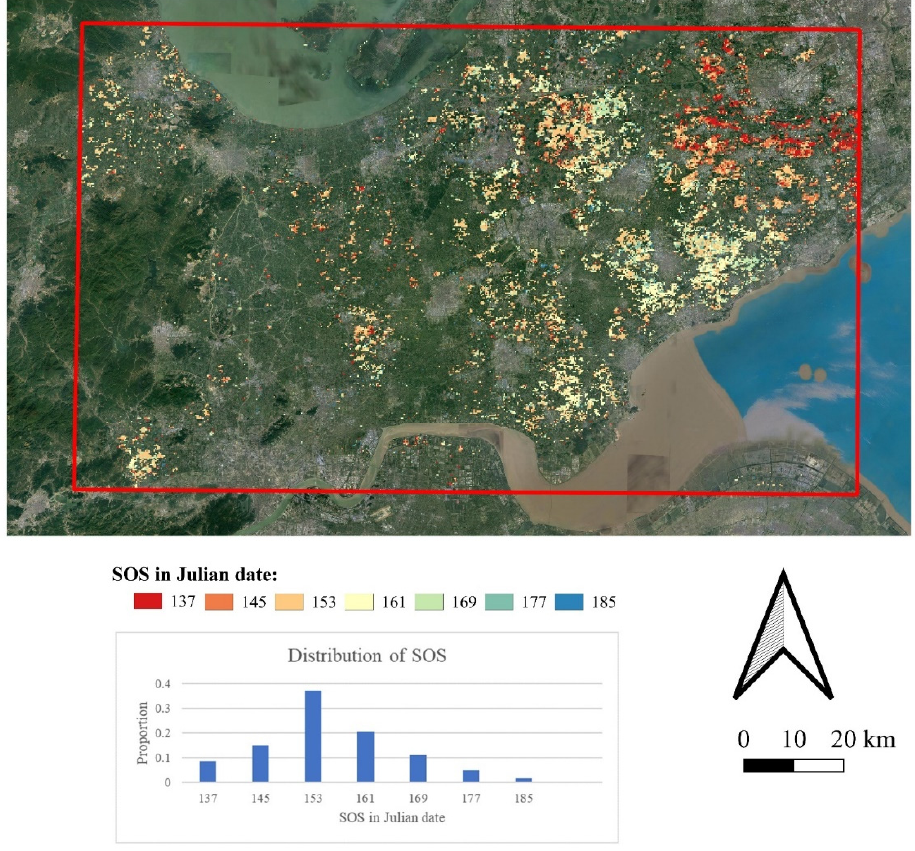
Figure 9. Pattern of the start of the season.